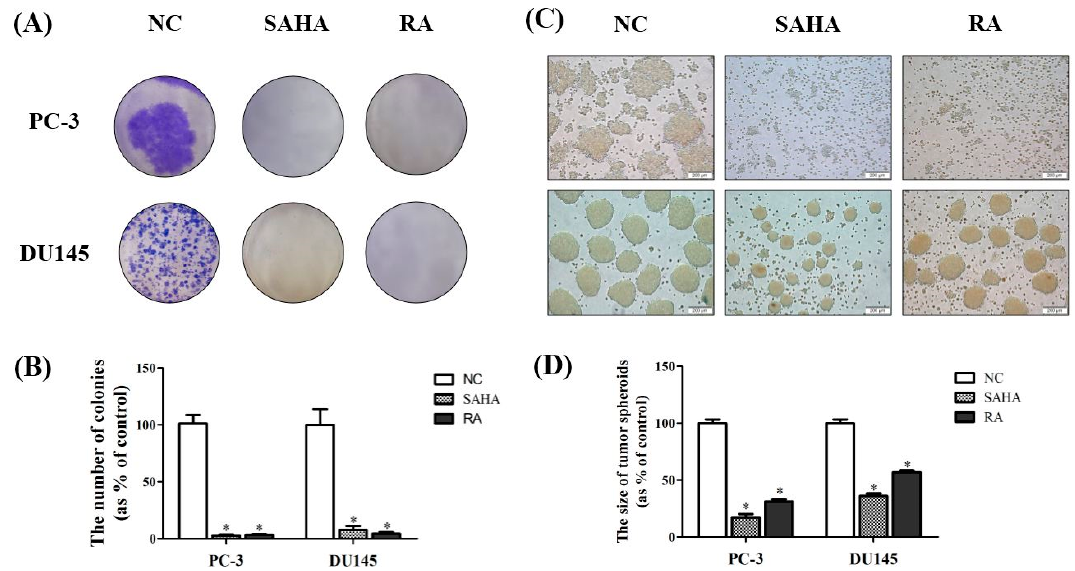
Figure 2. Effects of SAHA and RA on formation of colonies and tumor spheroids in PC-3 and DU145 cell lines. ( A ) After both cell lines were seeded at 5 × 10 3 cells per well in 6-well plates and treated with media containing NC (DMSO), SAHA (1 µ M) and RA (200 µ M), colonogenic assay was performed to measure the colony formation. ( B ) The number of colonies was quantified by using the Image J program. ( C ) Both cell lines in media containing NC (DMSO), SAHA (1 µ M) and RA (200 µ M) were seeded on petri dish covers at 3 × 10 3 cells in 25 µ L. ( D ) The size of tumor spheroids was measured by using the Image J program. The results are expressed as means ± SD. * p < 0.05: a significant difference versus control.